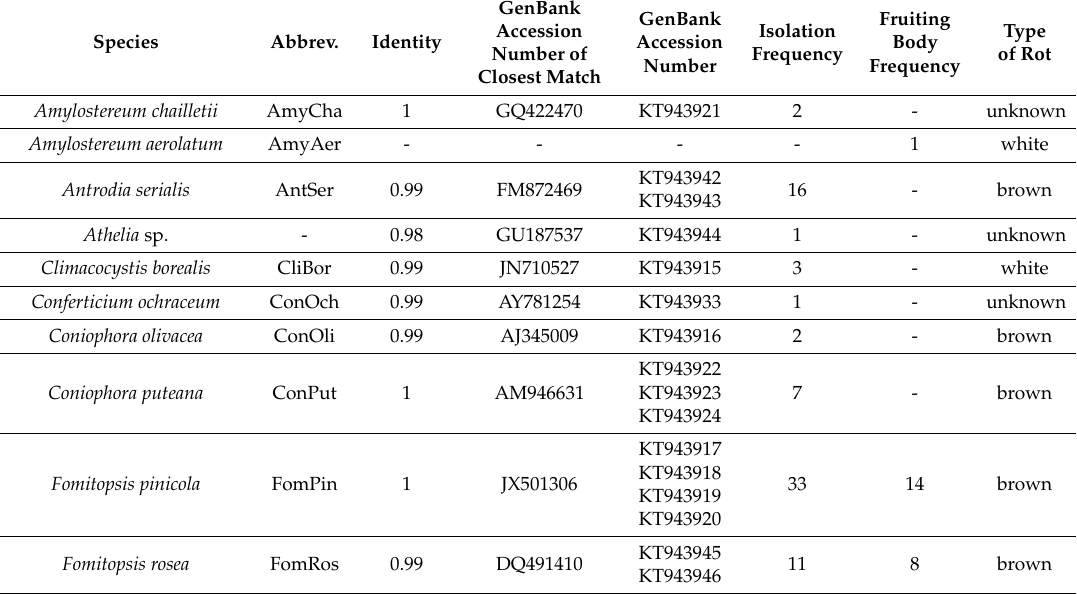
Table 3. Macroscopically identified and sequenced wood decay fungi, GenBank accession number of closest match and own isolates, frequencies and type of rot